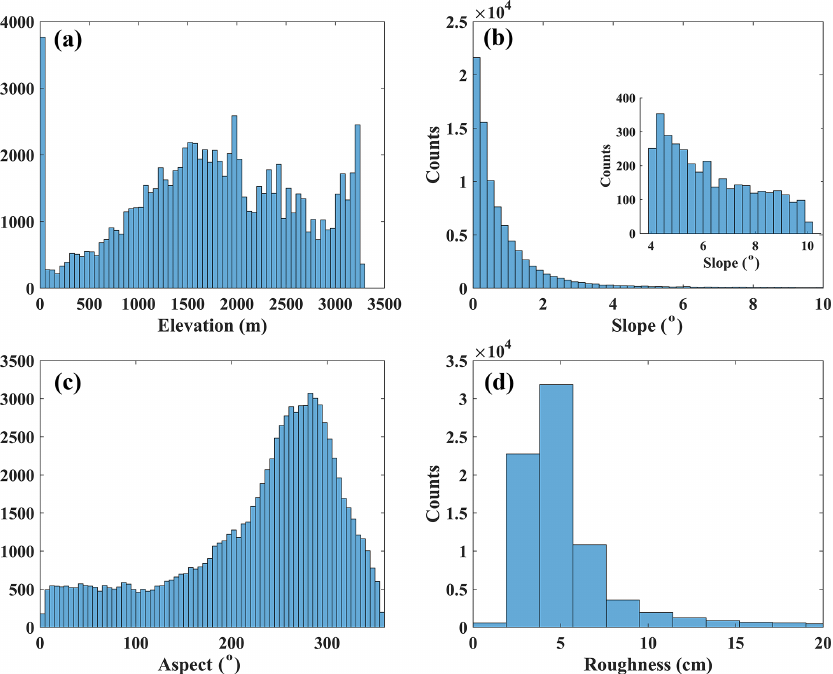
Figure 2. Histogram of the (a) surface height, (b) surface slope, (c) aspect, and (d) roughness derived from IceBridge data. The inset figure shows the histogram of surface slope between 4 and 10 ◦ . Table 1. Published Greenland DEMs used in this study. Note that the ArcticDEM has higher resolutions of 2, 10, 32, and 100m and that we used only resolutions of 500 and 1000m for